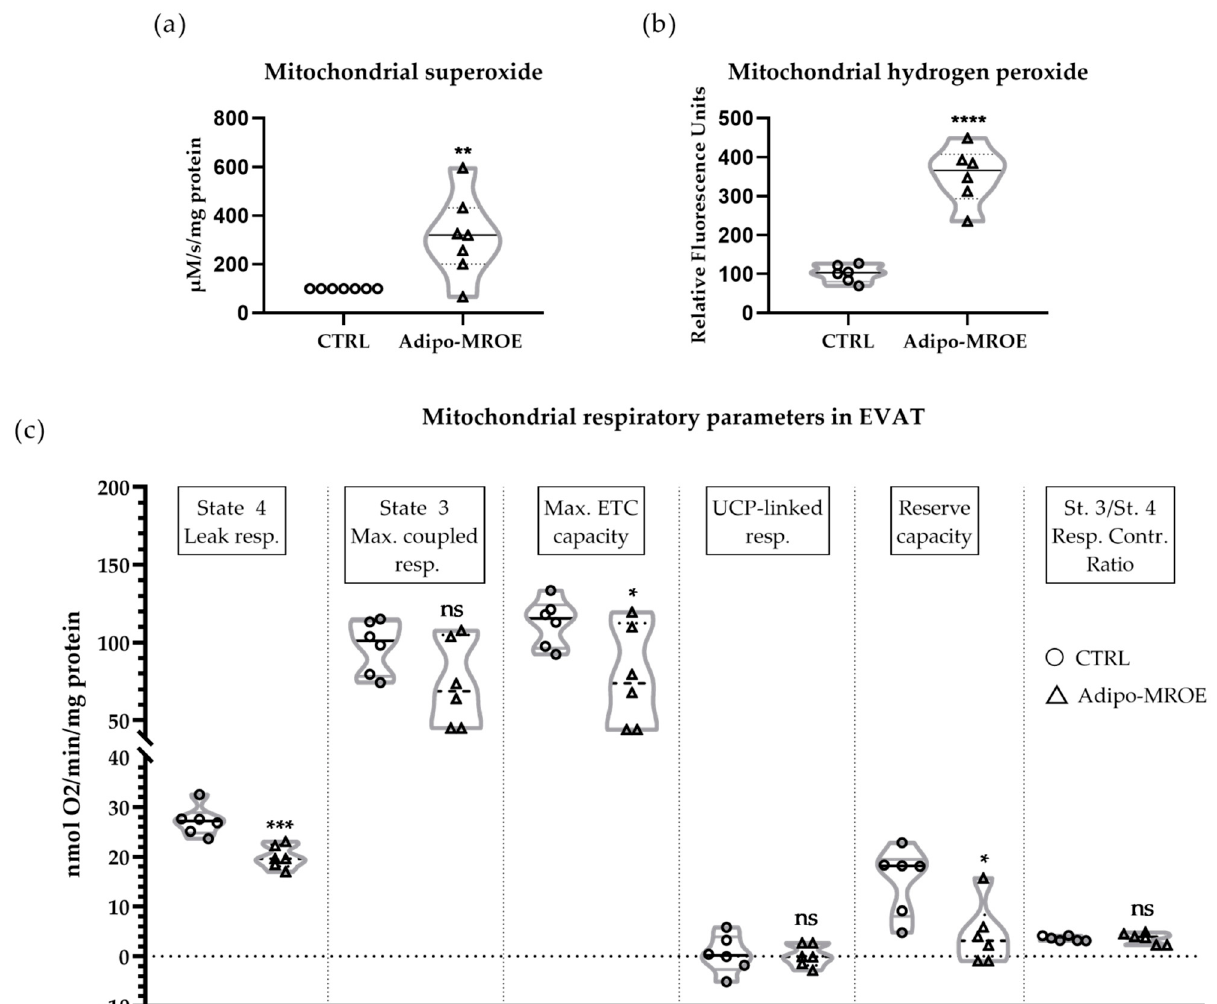
Figure 3. MR-dependent AT OS is linked to mitochondrial OS and altered mitochondrial respiration in the EVAT of adipocyte-MR overexpressing mice. ( a ) EVAT mitochondrial superoxide-as measured by electron paramagnetic resonance (EPR)-and ( b ) the mitochondrial hydrogen peroxide concentration-as measured with Amplex Red assay-are increased in Adipo-MROE mice, showing mitochondrial OS; ( c ) measurement of mitochondrial respiration with the Oroboros O2k- Oxygraph shows decreased state 4 leak respiration and unchanged state 3 maximal coupled respiration in Adipo-MROE mice; leak respiration is not linked to uncoupling proteins (UCP) activation, as shown by the absence of UCP-dependent uncoupling (no effect of the UCP-specific inhibitor GDP) in both groups. Maximal electron transfer chain (ETC) capacity, reflecting ETC function, and reserve capacity-an indicator of energy furniture flexibility-are decreased in Adipo-MROE mice. Data are expressed as violin plots with quartiles and individual dots. n = 6 mice per group; * p < 0.05; ** p < 0.01; *** p < 0.001; **** p < 0.0001; ns = not significant, Adipo-MROE vs control. Contr.: control; ETC: electron transport chain; EVAT: epididymal visceral adipose tissue; GDP: guanosine diphosphate; MR: mineralocorticoid receptor; OS: oxidative stress; Resp.: respiration; UCP: uncoupling protein.